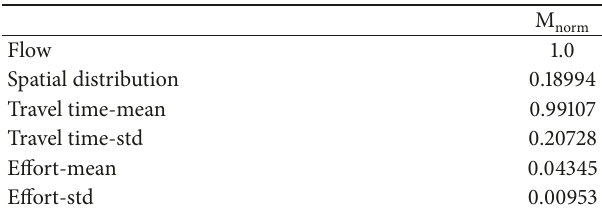
Table 2: Normalization